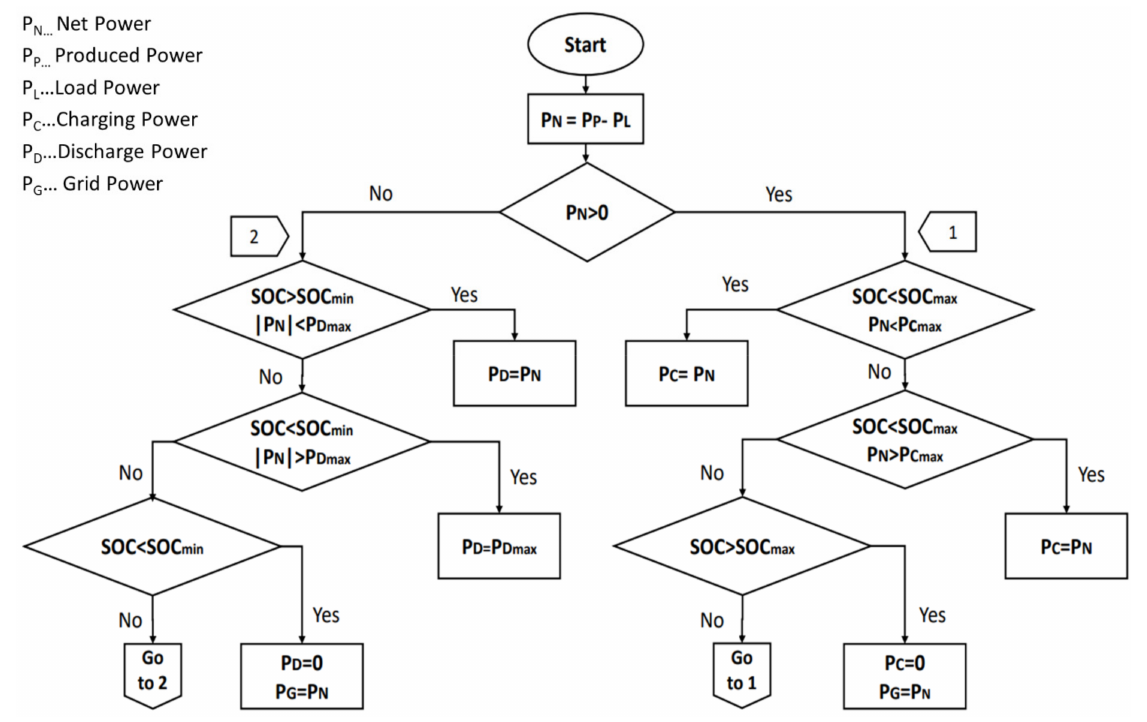
Figure 6. Flow chart of the proposed algorithm for the electrical part of the HPS controlled by the battery bank.